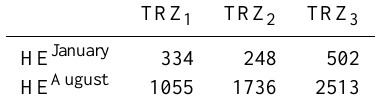
2.3 Vulnerability ( V ) The vulnerability represents the fraction of the ex- stroyed/damaged during a calamitous tsunami